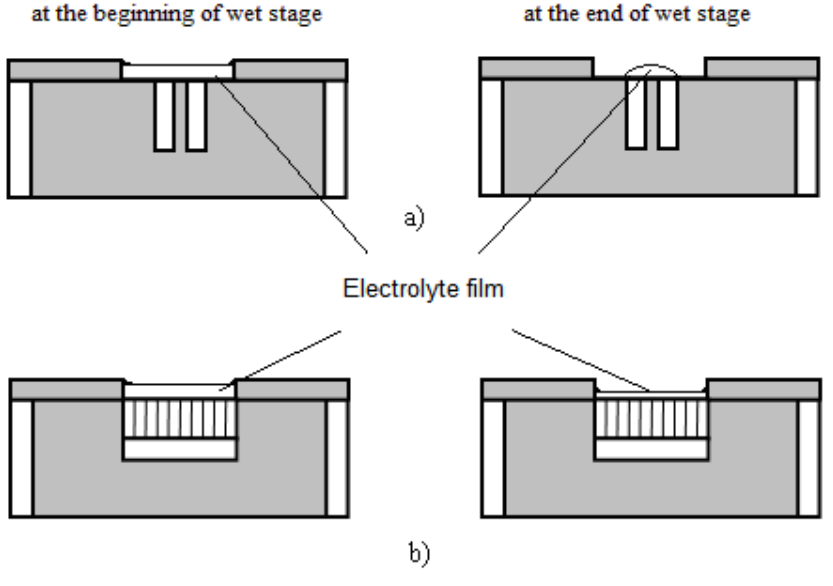
Figure 3. Comparison of different electrodes during the wet stage. (a) chip-shaped electrode. (b) comb-shaped